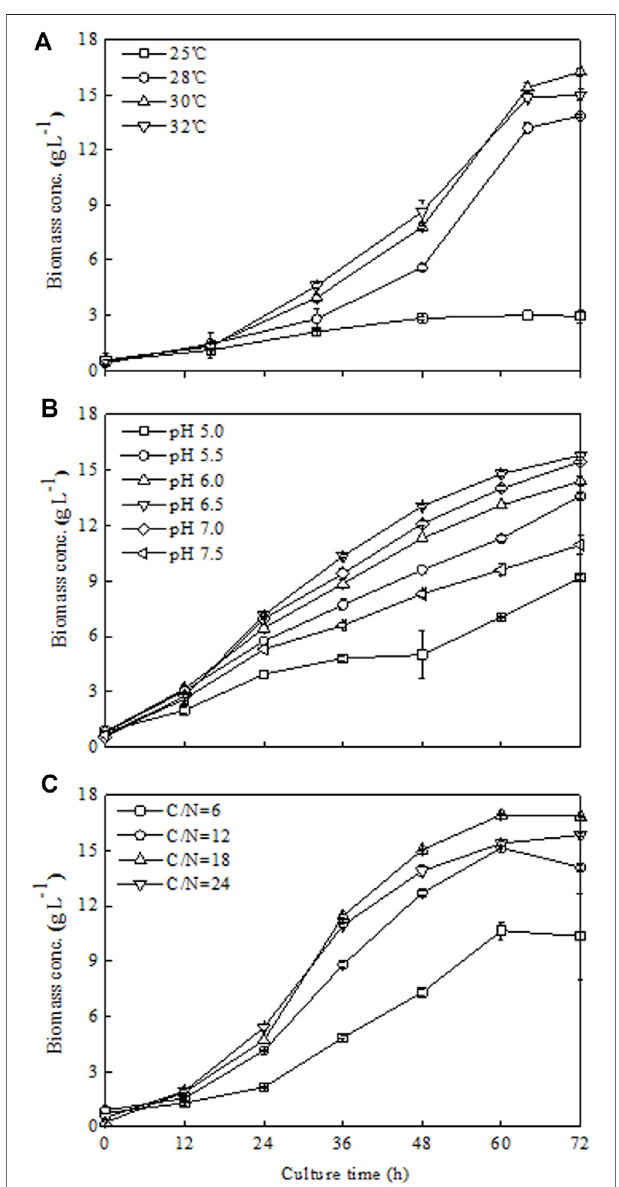
FIGURE 2 | Effects of different temperatures (A) , pH (B), and C/N ratios (C) on C. sorokiniana CMBB276 growth under heterotrophic conditions in 1-l bioreactors. Values are shown as mean ± SD from three biological independent replicates.